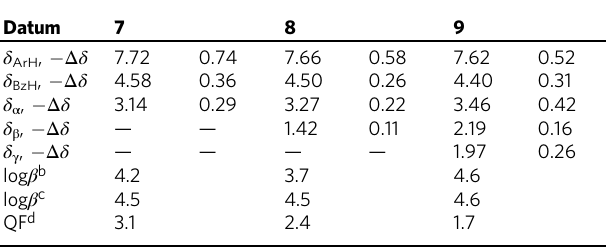
Table 1 1 H NMR and fl uorescence emission spectroscopic data for complexation of 4 and 7 – 9